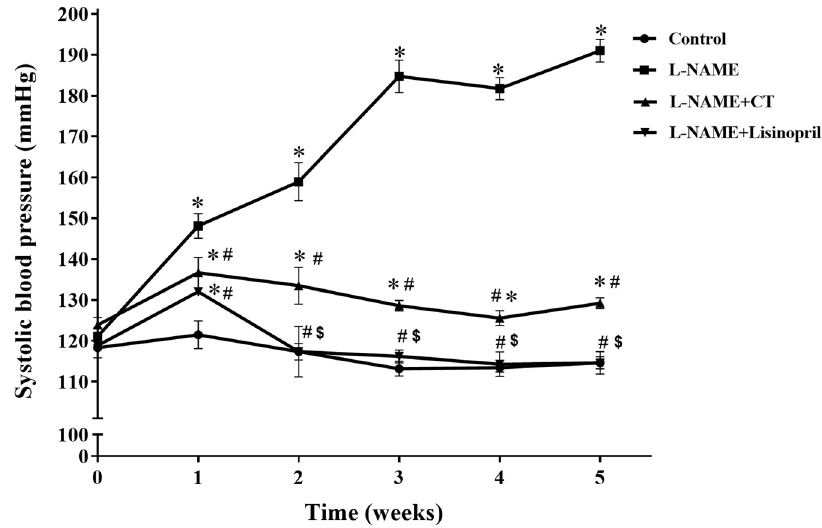
Figure 1. Effects of CT extract and lisinopril on systolic blood pressure in conscious rats. Data are expressed as mean ± SEM ( n = 8/group), * p < 0.05 vs. control, # p < 0.05 vs. L-NAME, $ p < 0.05 vs. L-NAME + CT. CT:; Clitoria ternatea Linn. extract. Table 2. Effects of CT extract and lisinopril on blood pressure, heart rate, heart weight per body weight, and left ventricular weight per body weight.